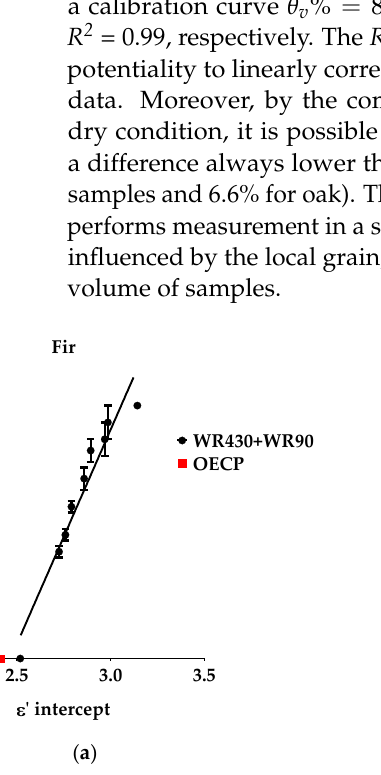
Table 1 above highlights how a water content increase corresponds to an increase in the b parameters for each wood. In Figure 5a–c, the calibration curves of water content are reported as a function of the vertical shift b ( ε (cid:48) ). For the fir sample, the calibration curve is θ v % = 7.61 · b − 17.78 with an R 2 = 0.96, while the poplar sample has a calibration